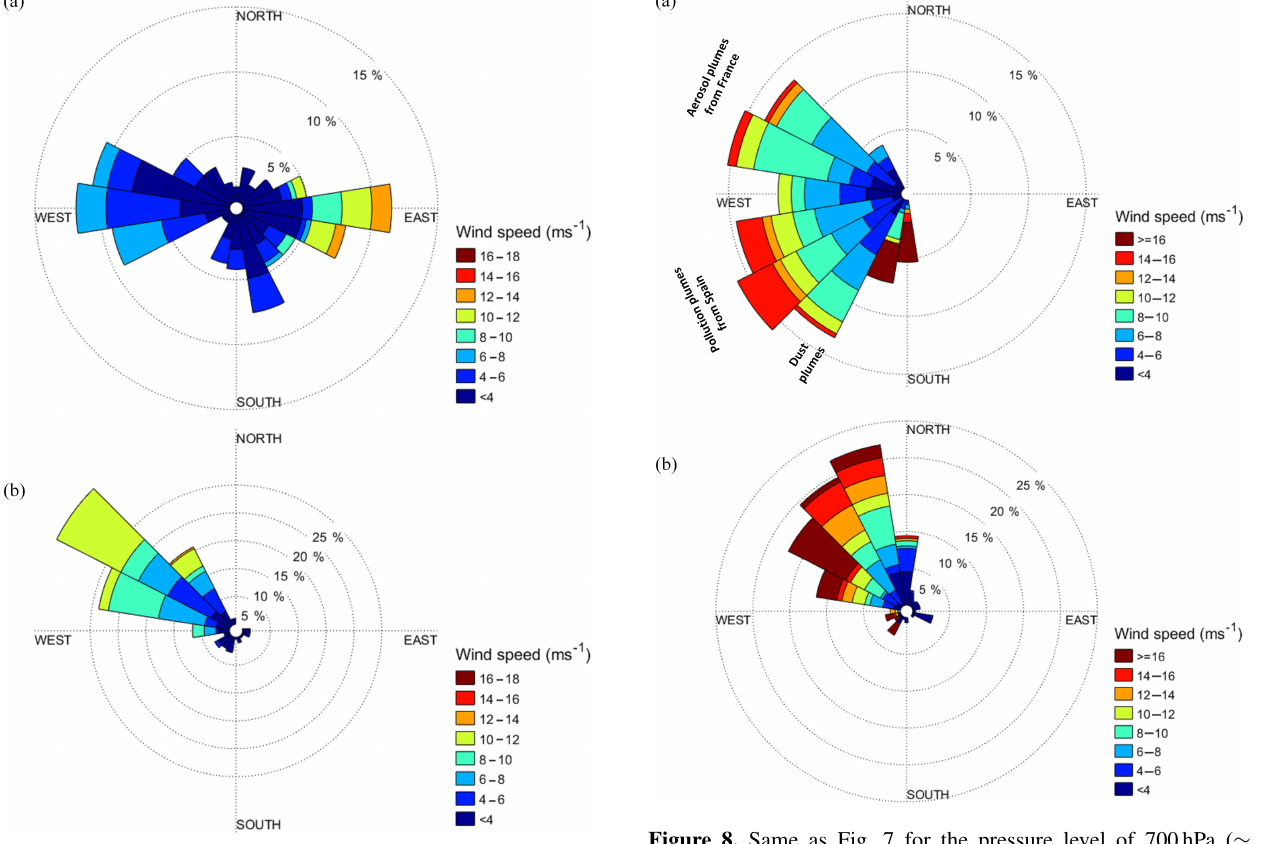
Figure 7. Frequency of counts (%) by wind speed direction at 975hPa ( ∼ 0 . 4kma.m.s.l.) for (a) disturbed cases, which are days with aerosol anomaly within the free troposphere, and (b) undis- turbed cases, which are days without anomaly. The hourly data are from the ERA5 reanalyzes at 0.25 ◦ of horizontal resolution and at the closest grid point from the station.